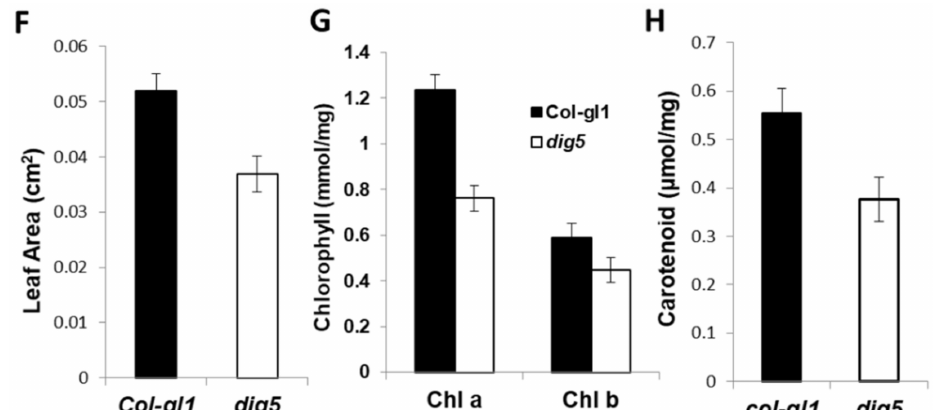
Figure 1. Phenotypes of the dig5 mutant. ( A – C ) Response of lateral roots of the wild-type Col- gl1 and dig5 seedlings to ABA. Three-day-old seedlings were transferred to the shown plate ( A ) without (control) or ( B ) with 0.5 µ M ABA and grown for 3 days before taking the pictures. ( C ) Lateral root number per seedling of the wild type and dig5 shown in ( A ). Data are means ± SD from 8 to 9 seedlings. ( D ) Morphology of 7-day-old seedlings of the wild type and dig5 growing on agar plates. ( E ) Morphology of adult plants growing in soil for one and a half months. ( F ) Leaf area of the first two rosette leaves of 1-week-old wild type and dig5 mutants grown in agar media. ( G ) Chlorophyll contents of the wild type and dig5 mutant leaves of 3-week-old seedlings grown in soil. ( H ) Carotenoid content of leaves of 3-week-old wild type and dig5 seedlings grown in